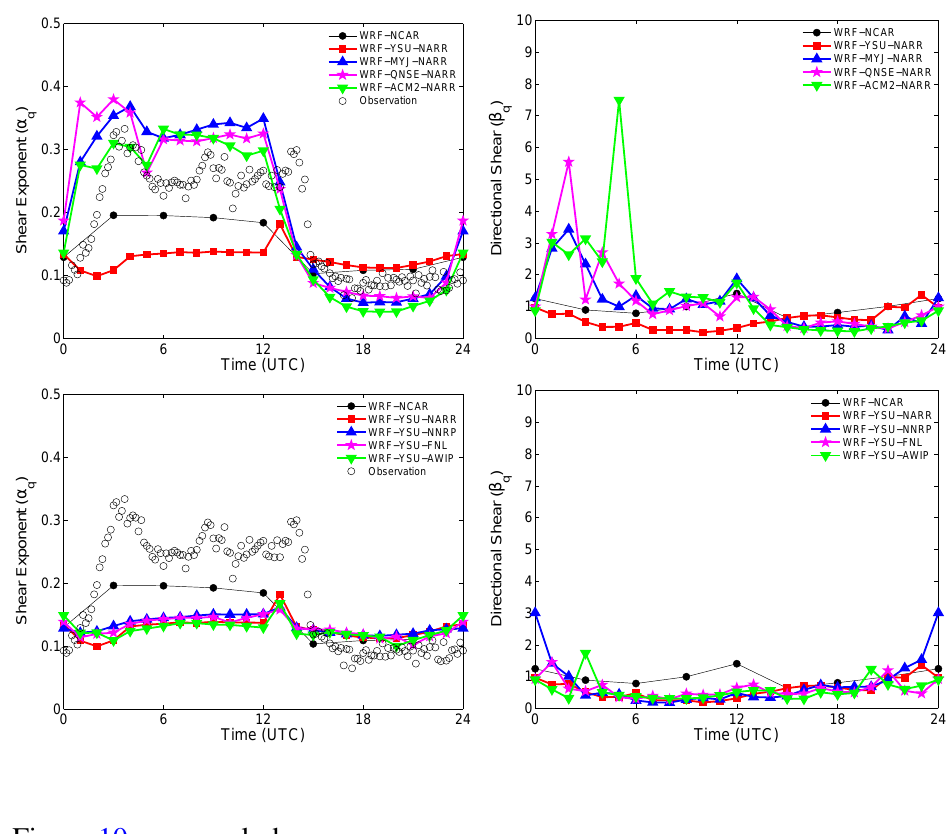
Figure 10. Diurnal variation of the observed and the WRF model forecast-derived wind shear exponents (left panel) and the directional shear magnitudes (right panel) at Sweetwater, TX. Study period: May 19, 2006–May 31,